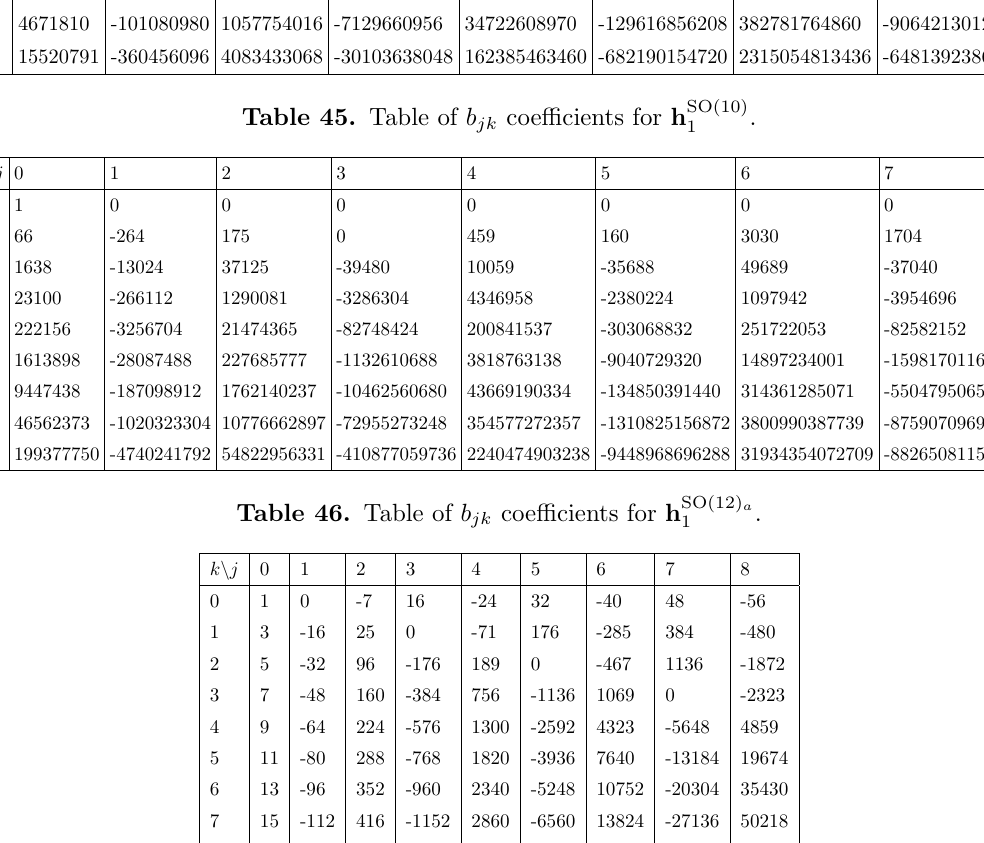
Table 47. Table of b jk coe(cid:14)cients for h SU(2)